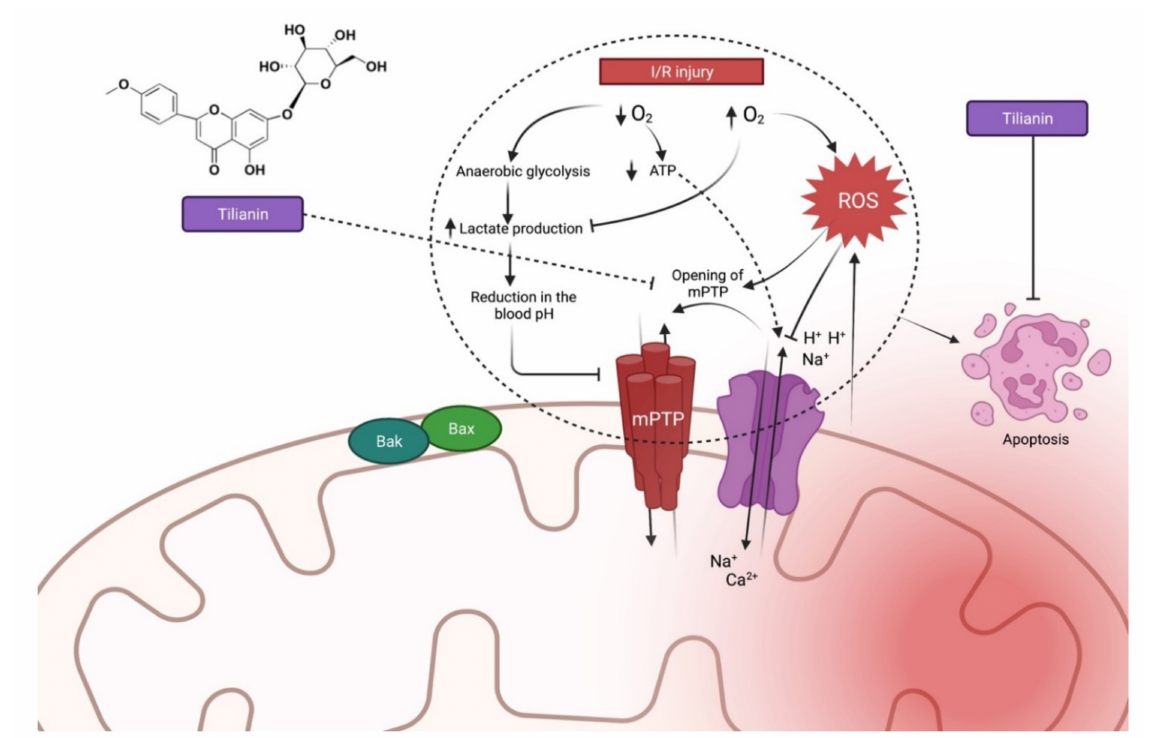
Figure 3. Possible mechanism of action of tilianin during I/R injury [21–25]. In the ischemic phase, less oxygen is produced, resulting in an increase in lactate production, lowering the blood pH. Reduced oxygen also results in the opening of the mPTP, which increases ROS formation during reperfusion. The series of events affects intracellular H + , Na + and Ca 2+ distribution, eventually result- ing in apoptosis. Abbreviations: ROS, Reactive oxygen species; mPTP, Mitochondrial permeability transition pore, Bax, Bcl-2 Associated X-protein; Bak, BCL2 Antagonist/killer.